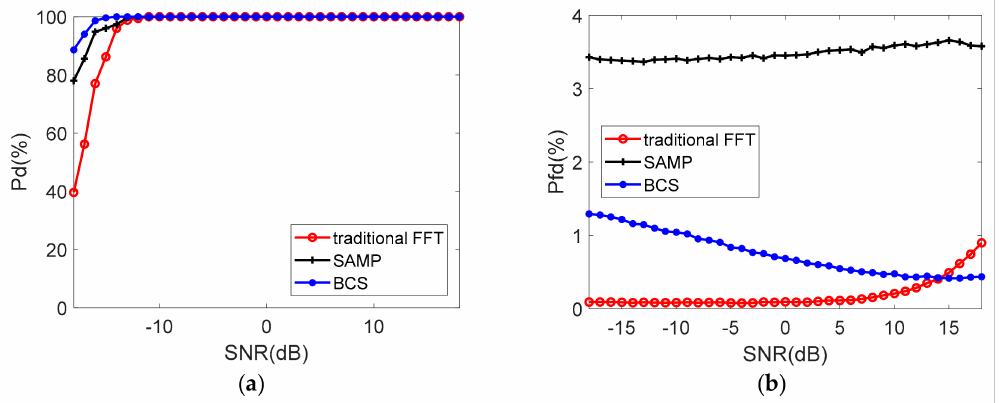
Figure 7. The probability of detection ( a ) and false detection ( b ) (single target, η = 65.7%).